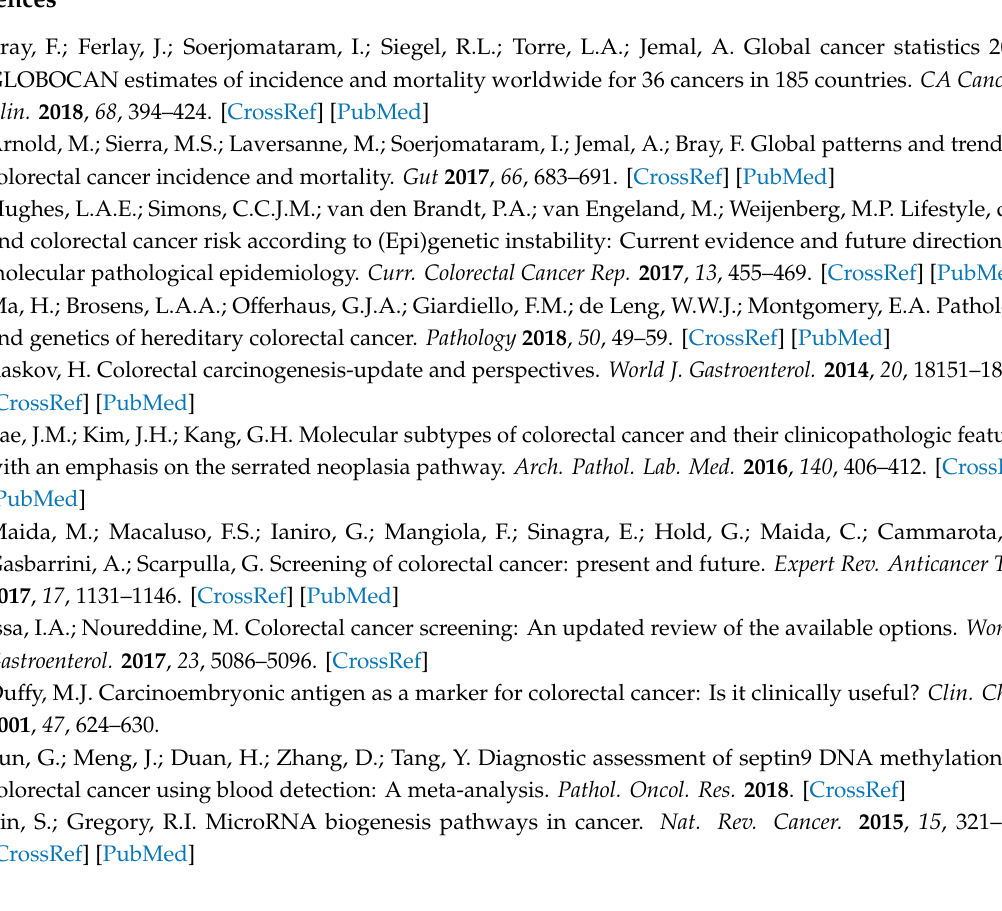
Table S1: Main findings of the included studies about circulating miRNAs in patients with CRC, Table S2: List of references of Figure 2, Table S3: List of references of Figure